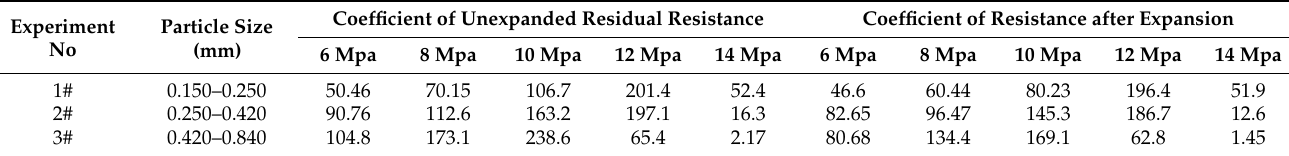
Table 11. Particle Residual Drag Coefficient Data